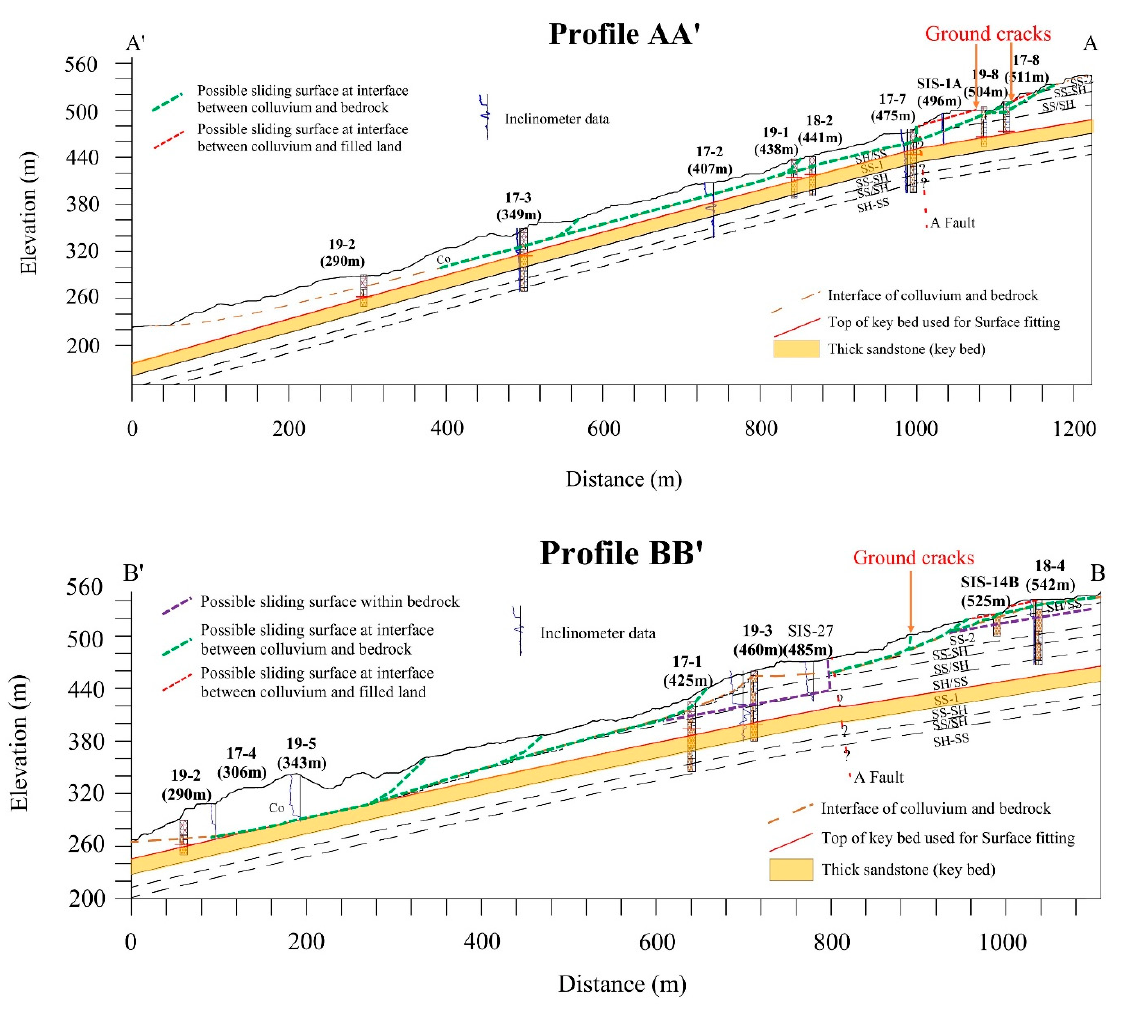
Figure 17. Potential sliding surfaces and projected inclinometer casing positions inside the slope in the profiles A-A’ and B-B’. The dashed green and dashed purple curves are inferred to be at the bottom of the colluvium and within the bedrock, respectively, based on rock cores and inclinometer measurements. The dashed red curve represents the sliding surface at the interface between the colluvium and the fill, revealed by considering the behavior of surficial displacements and topographical features.